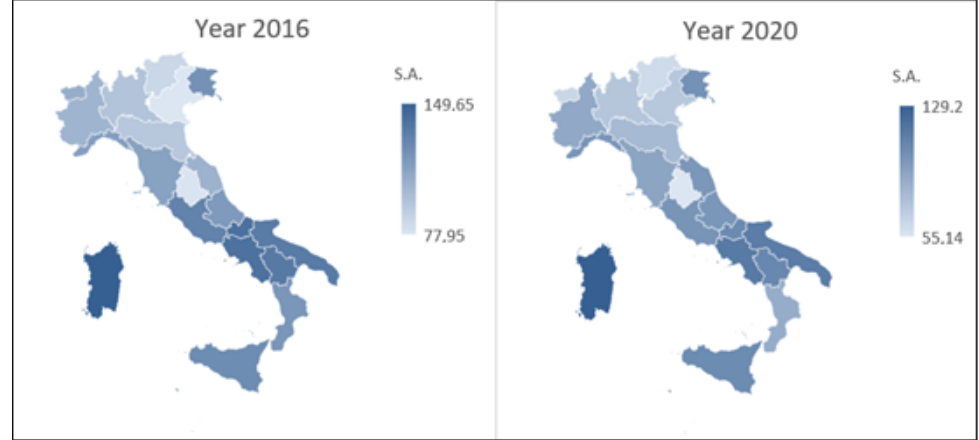
Figure 1. Cartogram of the Italian territory according to SA standardized rates (years 2016 and 2020).